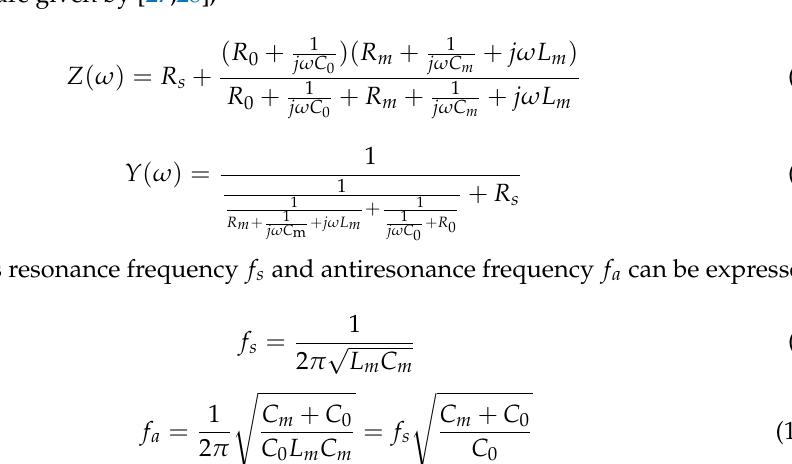
Figure 3. The modified Butterworth–Van Dyke (MBVD) circuit for the ME sensor.